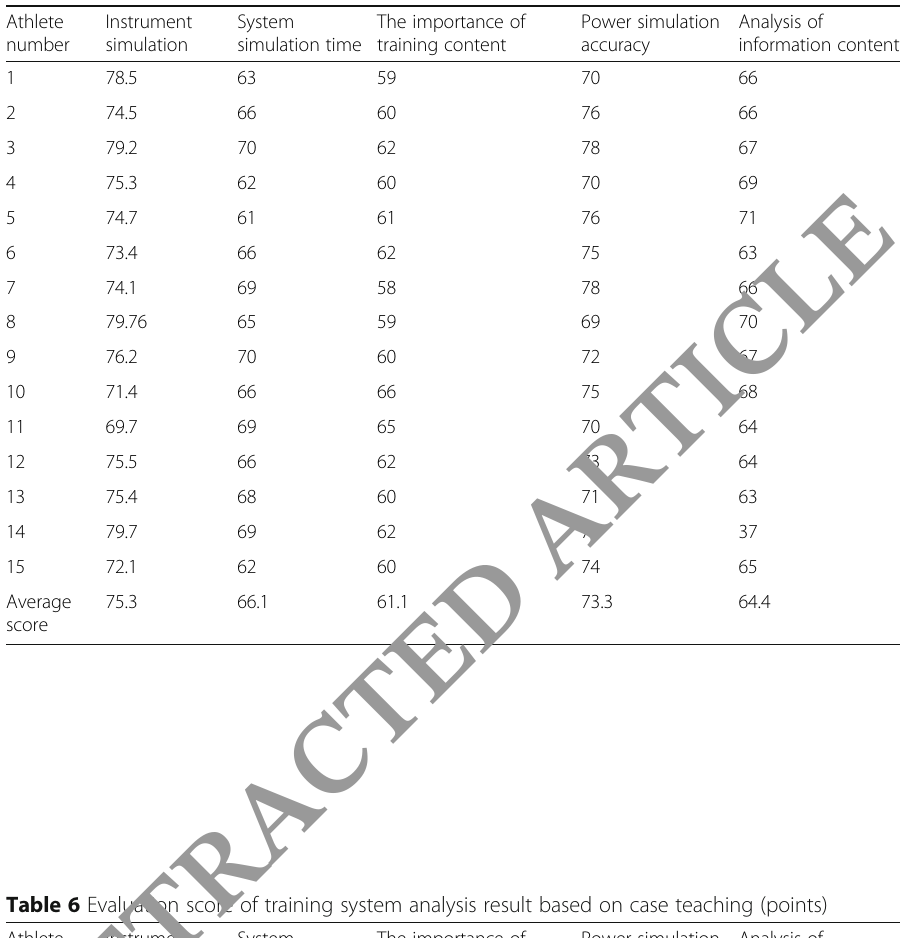
Table 5 Evaluation score of training system analysis results based on event driven programming